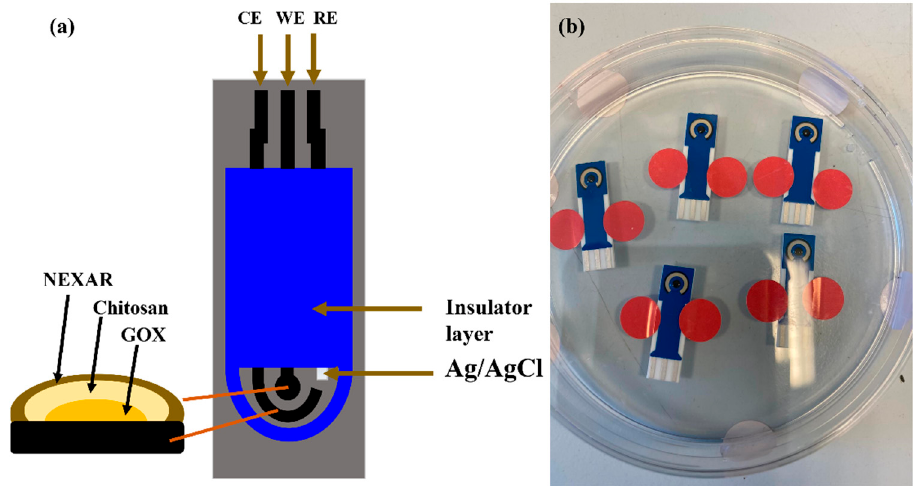
Figure 1. Characterization of the glucose sensor. ( a ). Schematic diagram of the glucose sensor. ( b ). Glucose-sensing electrode, coated with five layers.